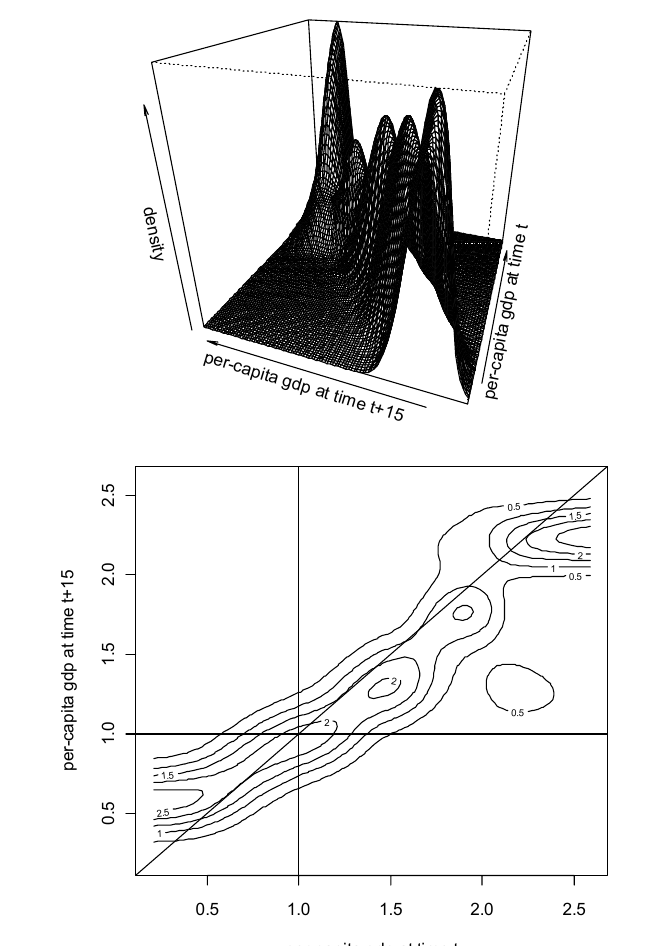
Figure 2 – Intra-Distribution Dynamics of regional per-capita income in Europe. Standard perspective plot (left hand side panel) and contour plot (right hand side panel) of condi- tional density for transitions of 15 years between 1980-2002. Estimates are based on a kernel den- sity estimator with fixed bandwidths (a = 0.132; b =